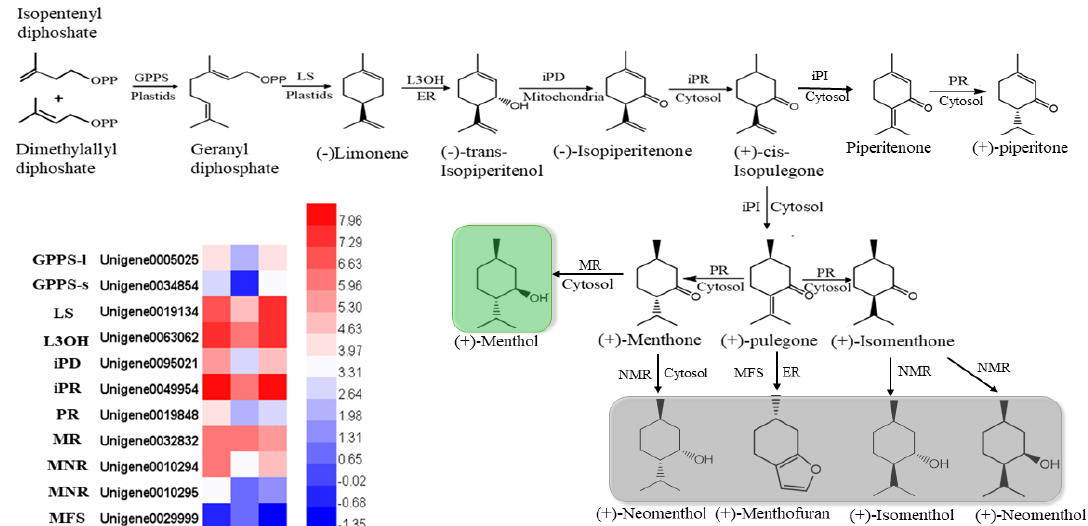
Figure 7. Heatmaps of the DEGs in the monoterpenoid biosynthesis pathway. GPPS-l, geranyl diphosphate synthase large subunit; GPPS-s, geranyl diphosphate synthase small subunit; LS, ( − )-limonene synthase; L3OH, ( − )-limonene-3-hydroxylase; iPD, ( − )-trans-Isopiperitenol dehydrogenase; iPR, ( − )-isopiperitenone reductase; iPI, (+)-cis-Isopulegone isomerase; PR, (+)-pulegone reductase; MFS, menthofuran synthase; MR, ( − )-menthol dehydrogenase. The green block show the final important compound, menthol; gray blocks show the branches of the final compounds.